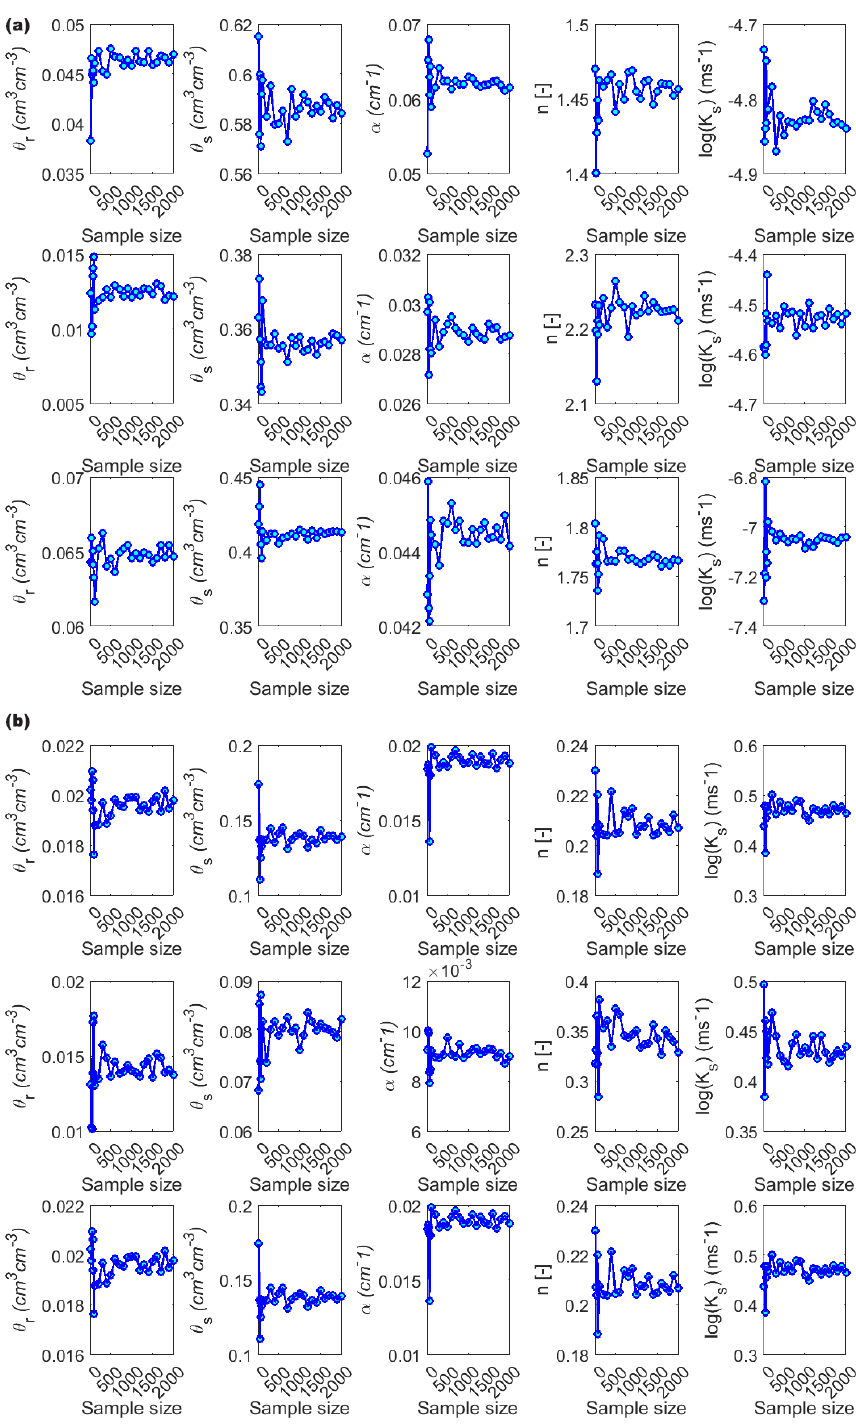
Figure A3. (a) Mean and (b) SD of the sampled parameter values corresponding to each sample size from the MC sampling method. Results are shown for peat (top row), subsoil (middle row), and LOS (bottom row) in both (a, b)